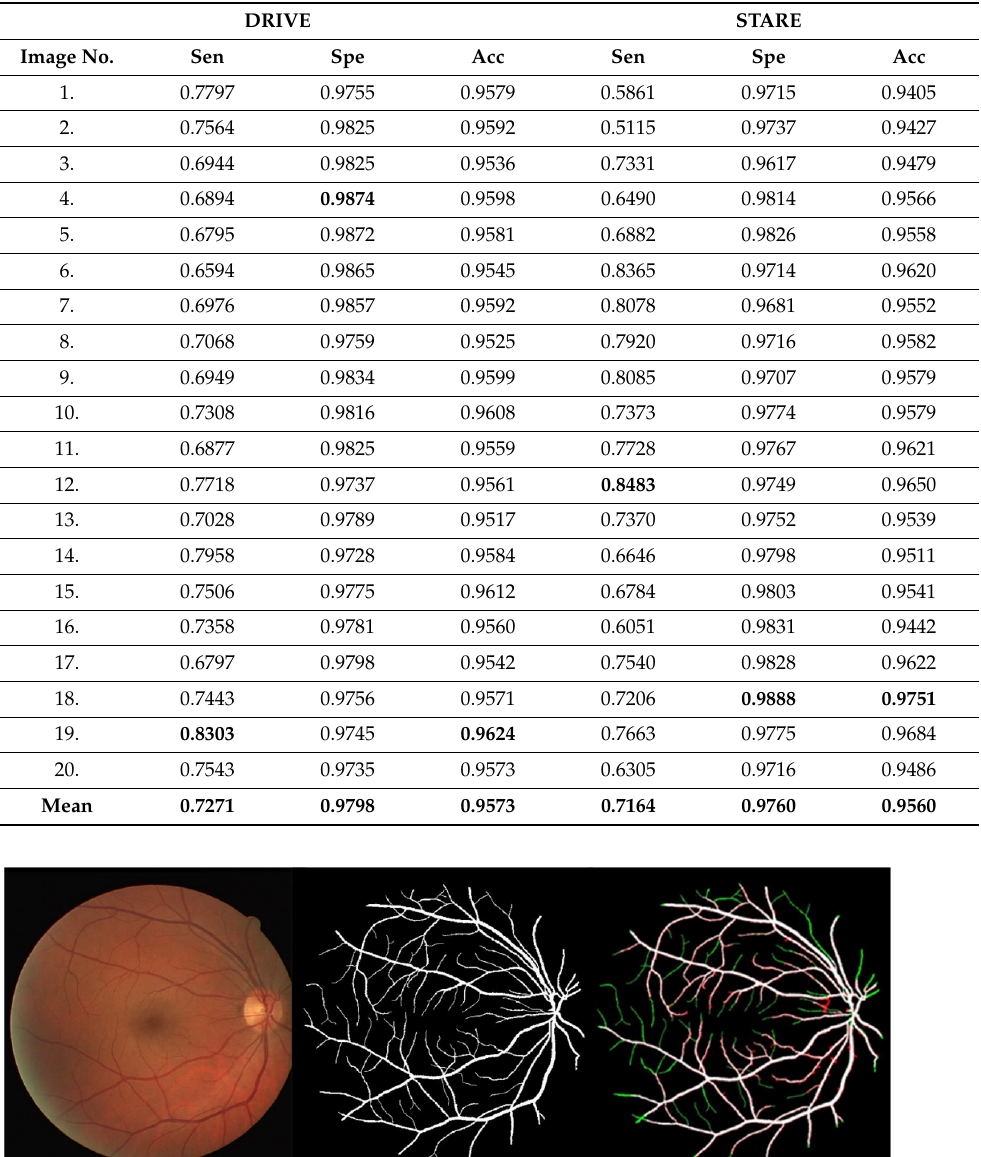
Table 3. Results of suggested technique.